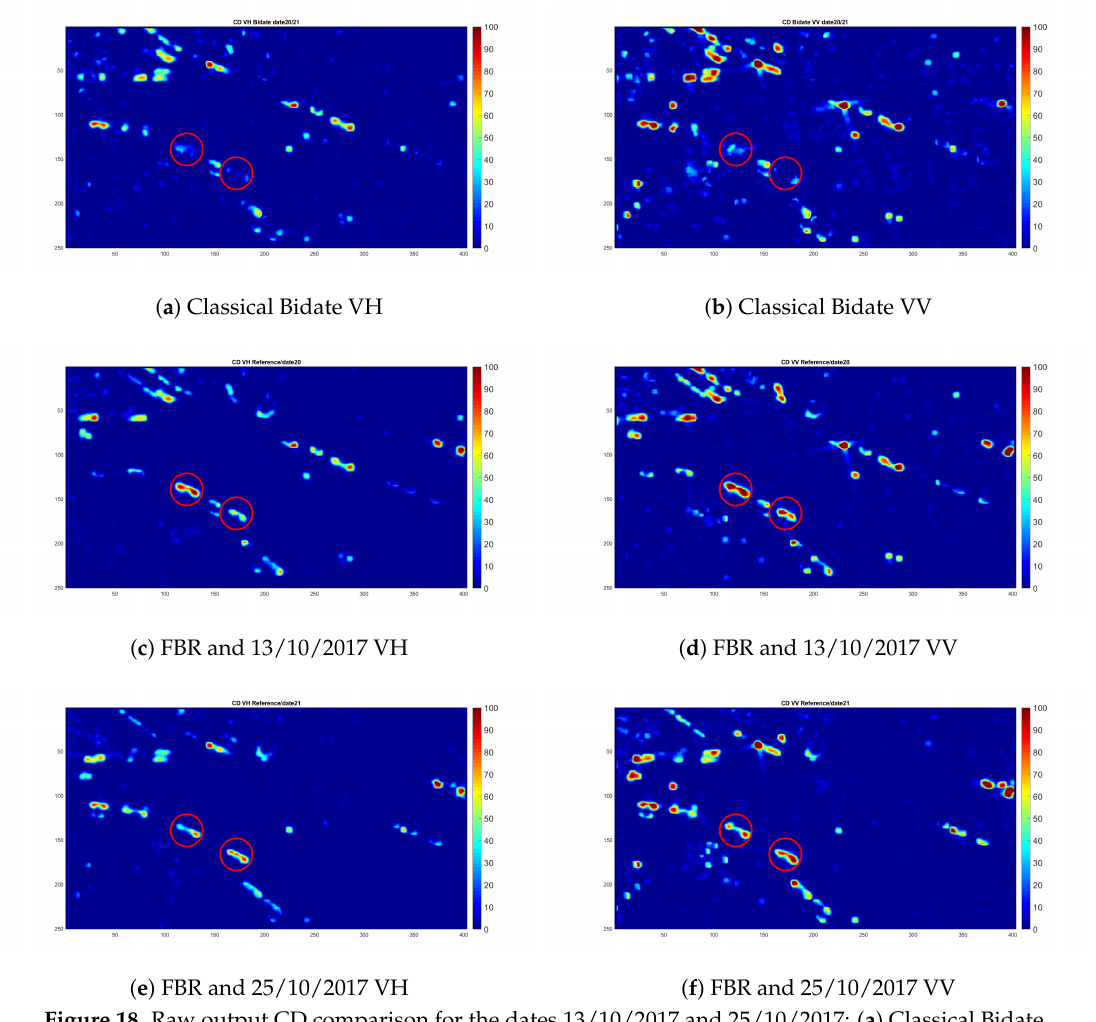
Figure 18. Raw output CD comparison for the dates 13/10/2017 and 25/10/2017: ( a ) Classical Bidate VH, ( b ) Classical Bidate VV, ( c ) CD FBR for date 13/10/2017 VH, ( d ) CD FBR for date 13/10/2017 VV, ( e ) CD FBR for date 25/10/2017 VH, ( f ) CD FBR for date 25/10/2017